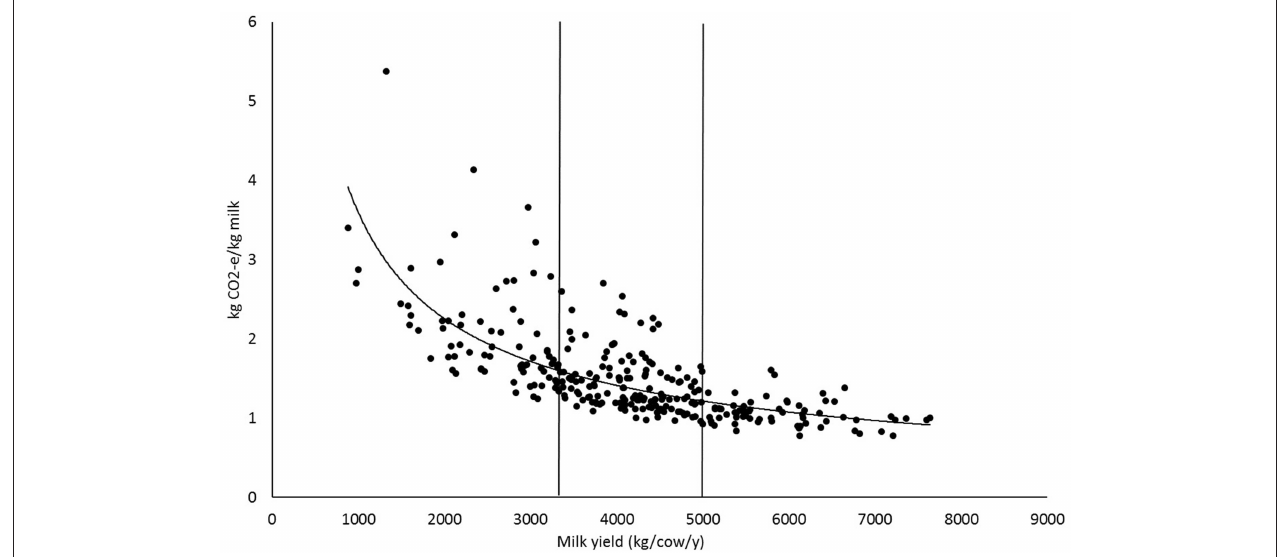
FIGURE 2 | Milk yield and greenhouse gas emission intensity of 283 dairy farms in Lembang Sub-district, West